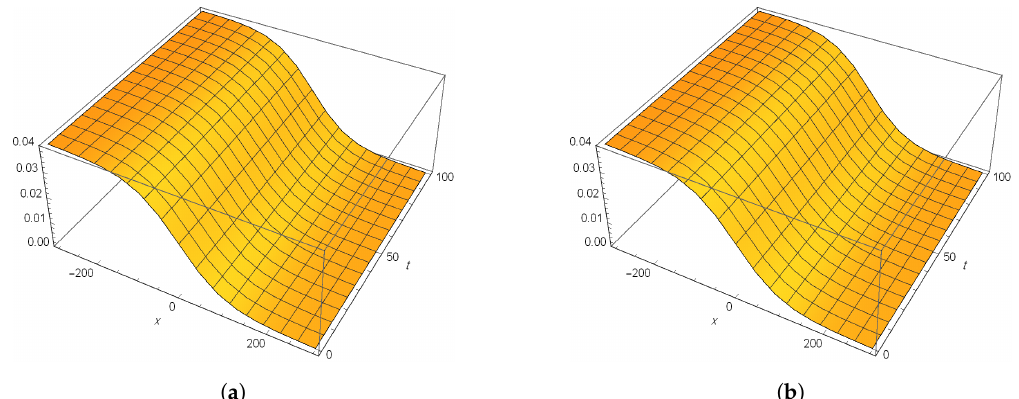
Figure 1. ( a ) The exact solution and ( b ) the third order approximation u 3 for α = 1, a = 1, b = 0.01, and c = 1.